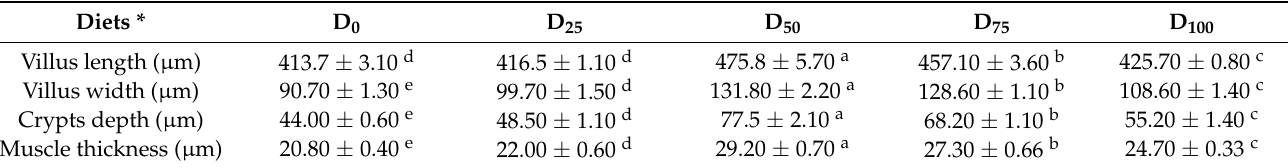
Table 7. Effect of partial or total replacement of fishmeal by amphipod meal, Gammarus pulex , on intestine morphology of Mugil cephalus